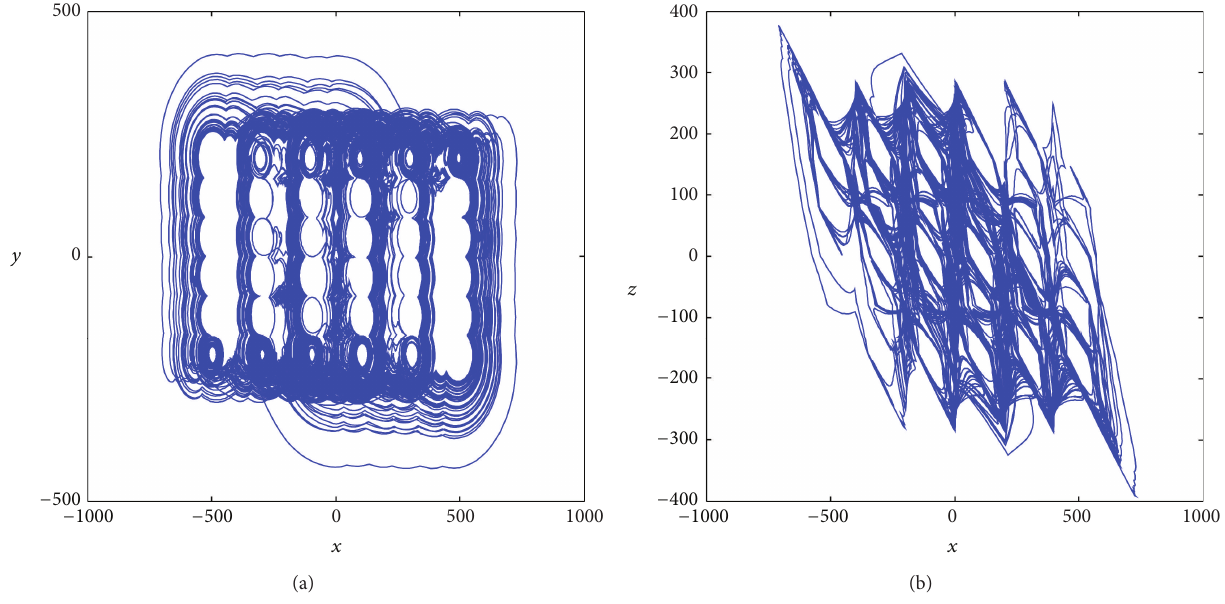
Figure 5: 3D multiscroll attractor: (a) 𝑥 − 𝑦 plane and (b) 𝑥 − 𝑧